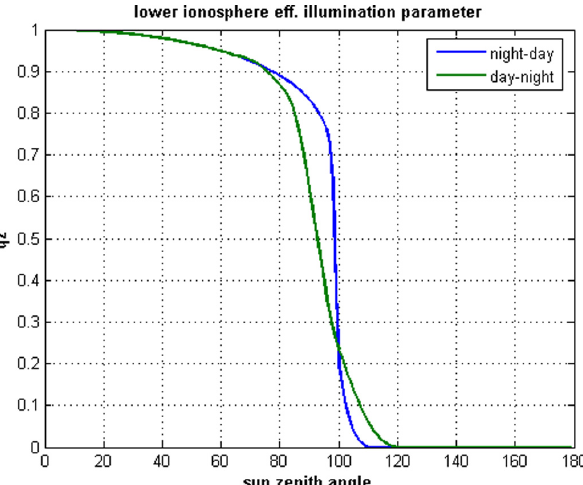
Fig. 8. Interpolation function for the electron density profile night/day parameters.